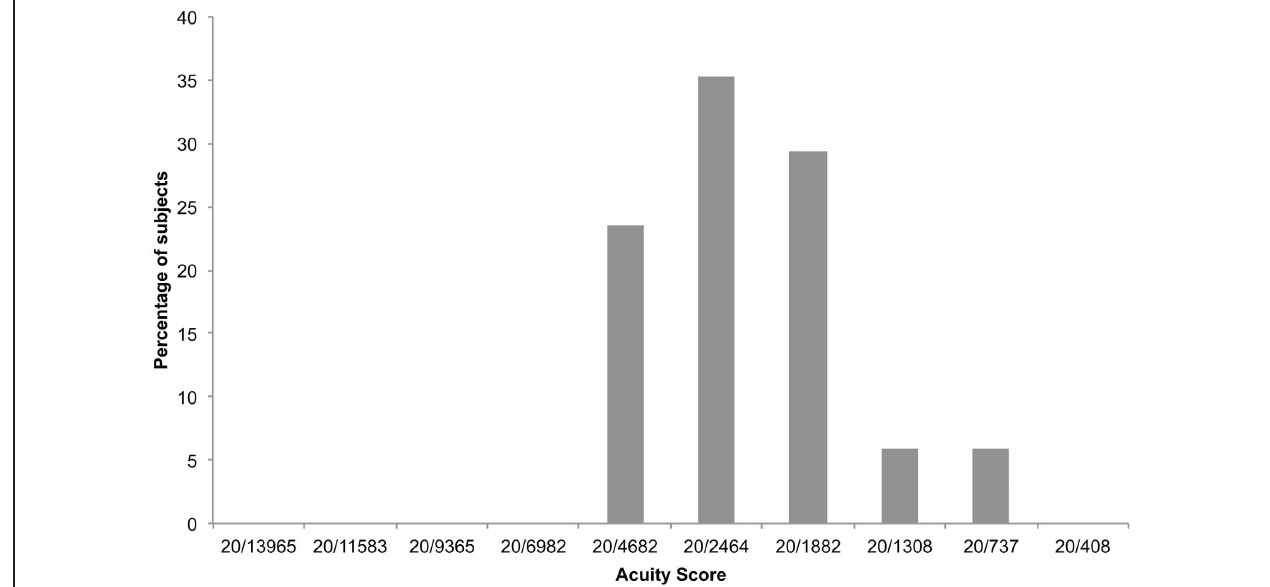
FIGURE 3 | Percentage of participants who achieved each vOICe acuity score (9/12 correct responses) in experiment 2.